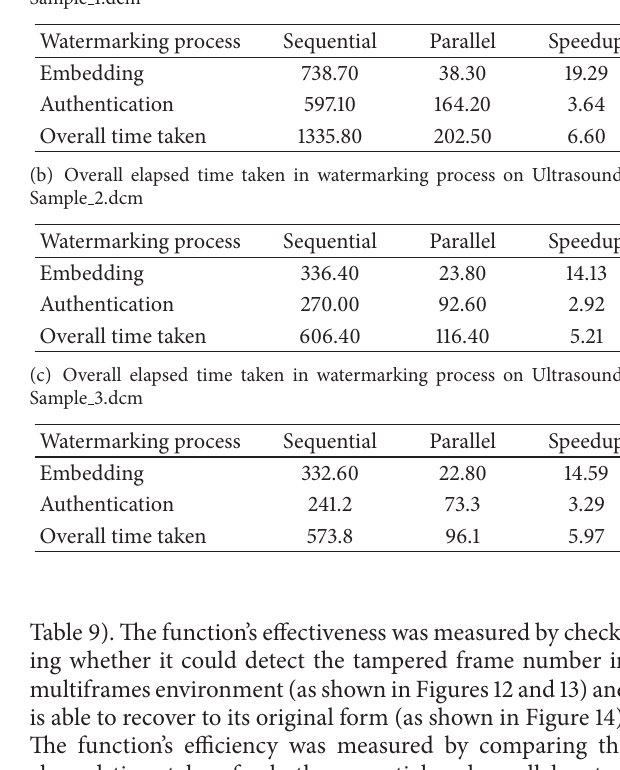
Table 8: The overall elapsed time comparison between sequential and parallel version of watermarking process (embedding plus